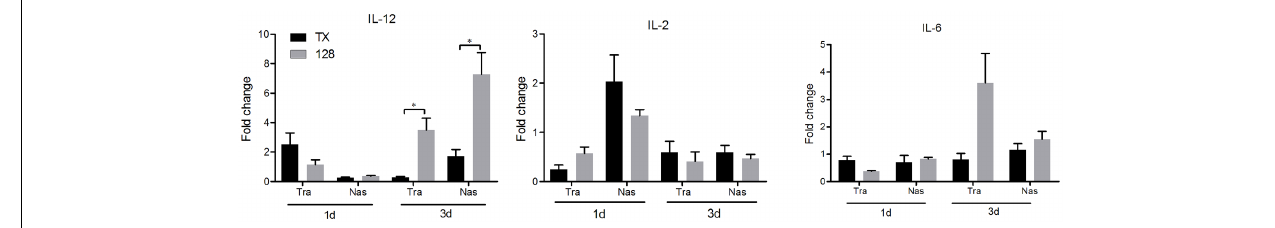
FIGURE 4 | Real-time quantification RT-PCR of cytokine gene expression. Chickens were immunized at 4 weeks of age, and the trachea and nasal tissues were sampled at 1 and 3 dpi. Total RNA was extracted and equal amounts of RNA (1 µ g) were used for RT-PCR. Gene expression was normalized to the β -actin gene expression level and presented as the fold increase relative to PBS-treated chickens. Data represent the mean fold changes ± standard errors. Asterisks represent p -values < 0.05.